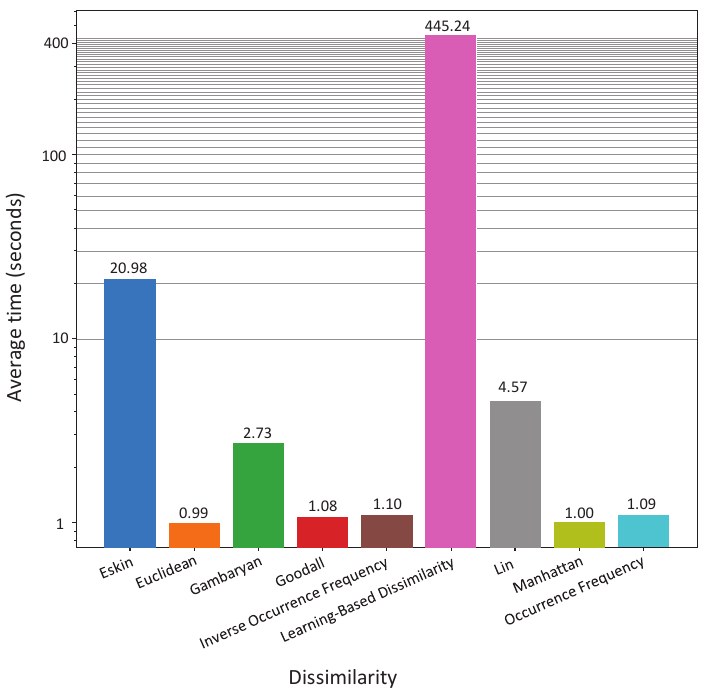
Figure 4. Average time of clustering with KMeans++ [15] using all the dissimilarity measures, considering all the tested datasets. The vertical axis is on a logarithmic